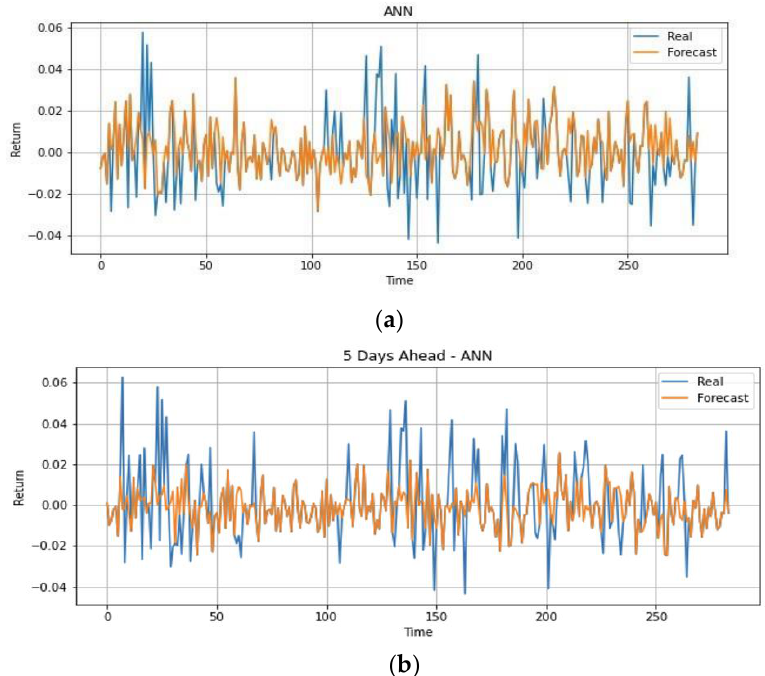
Figure 7. ANN Forecasting Result for One-Day- ( a ) and Five-Day-Ahead ( b ).